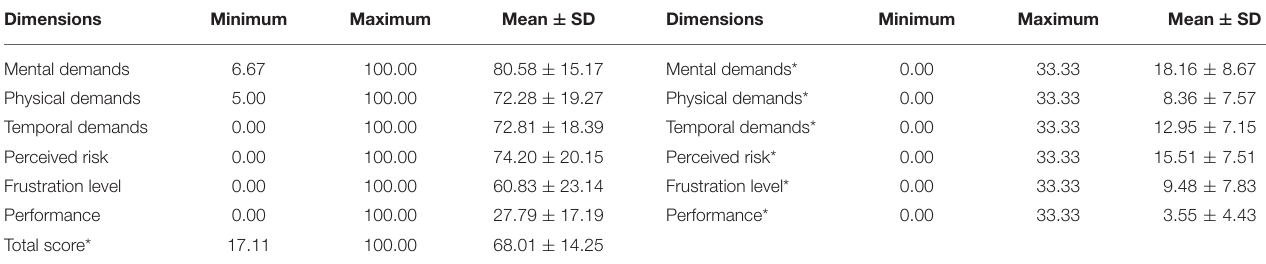
TABLE 2 | Mean mental workload scores ( n = 1,934).